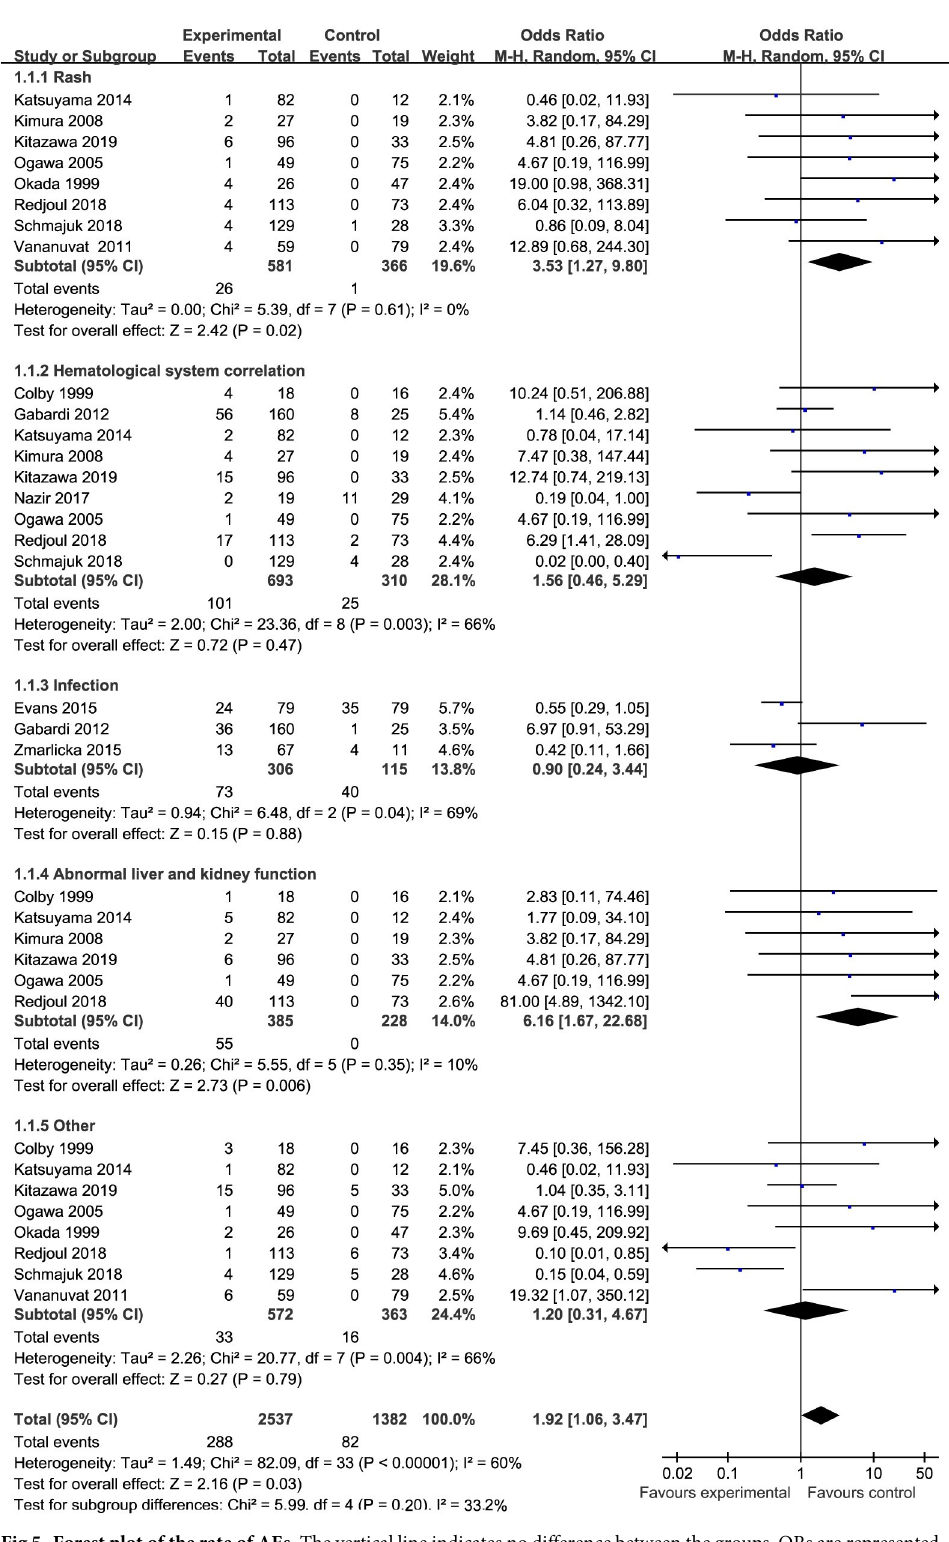
PLOS ONE | https://doi.org/10.1371/journal.pone.0248524 March 25,